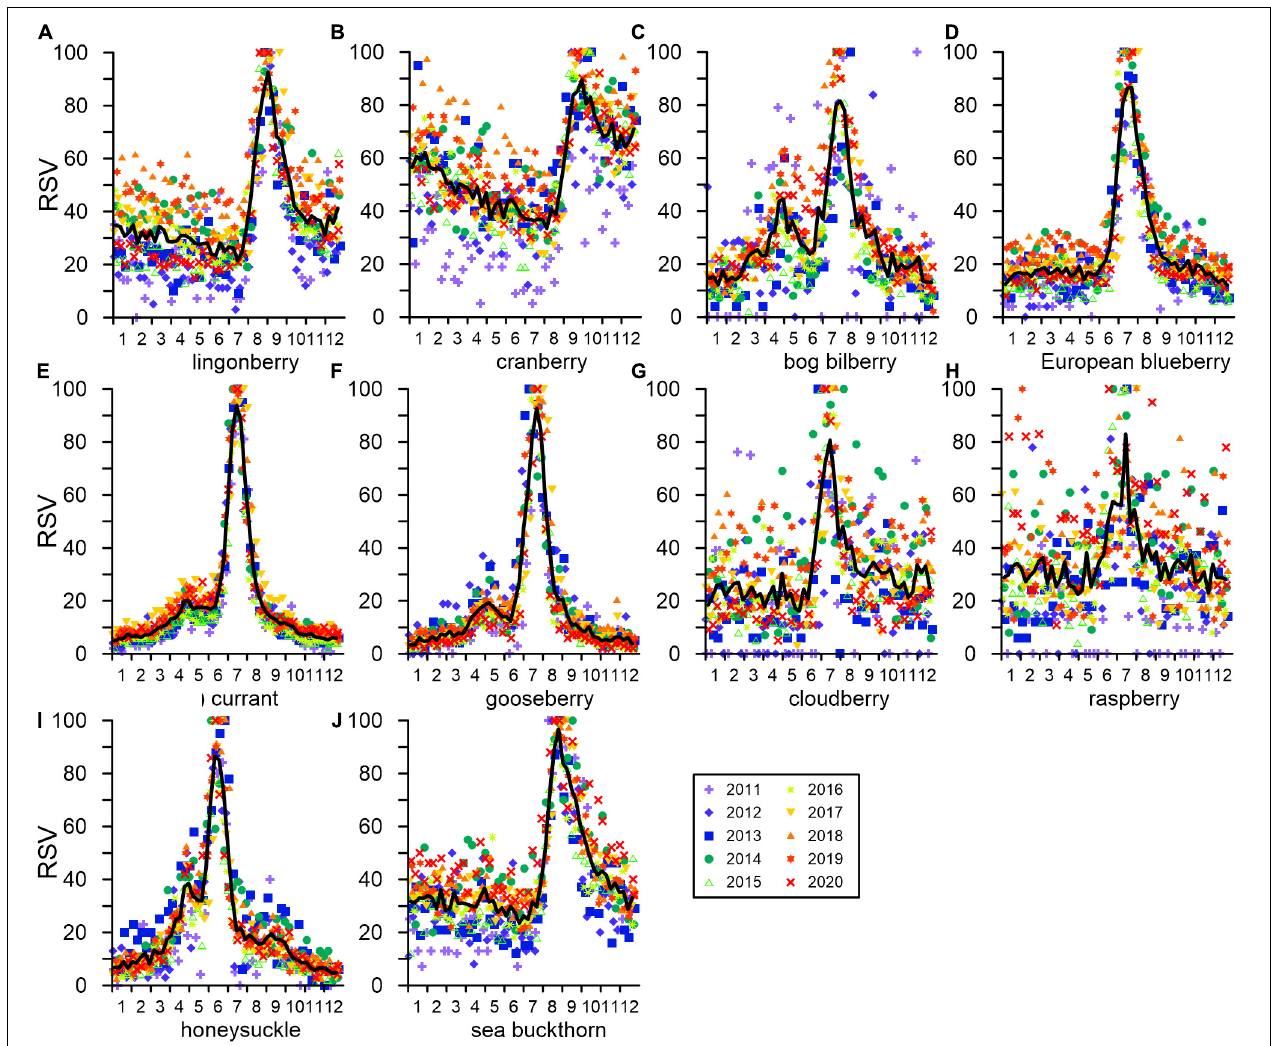
FIGURE 4 | Weekly relative search volume (RSV) for each year of (A) lingonberry, (B) cranberry, (C) bog bilberry, (D) European blueberry, (E) currant, (F) gooseberry, (G) cloudberry, (H) raspberry, (I) honeysuckle, and (J) sea buckthorn across Russia. Lines indicate 10 year mean of weekly RSV.